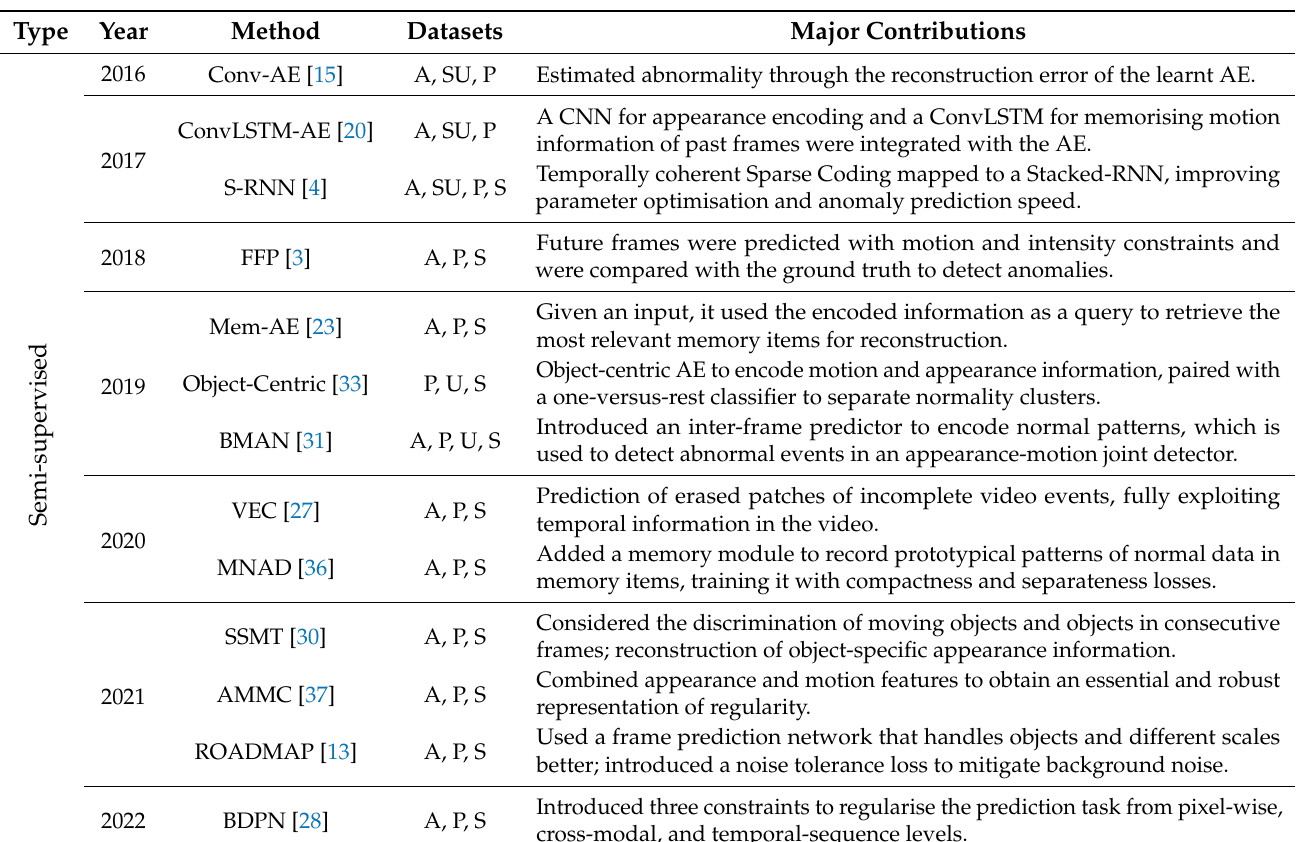
Table 4. Summary of the most relevant surveyed methods. Abbreviations: A = CUHK Avenue [11], SU = Subway (Entry and Exit) [57], P = UCSD Pedestrian [12], U = UMN [58], S =